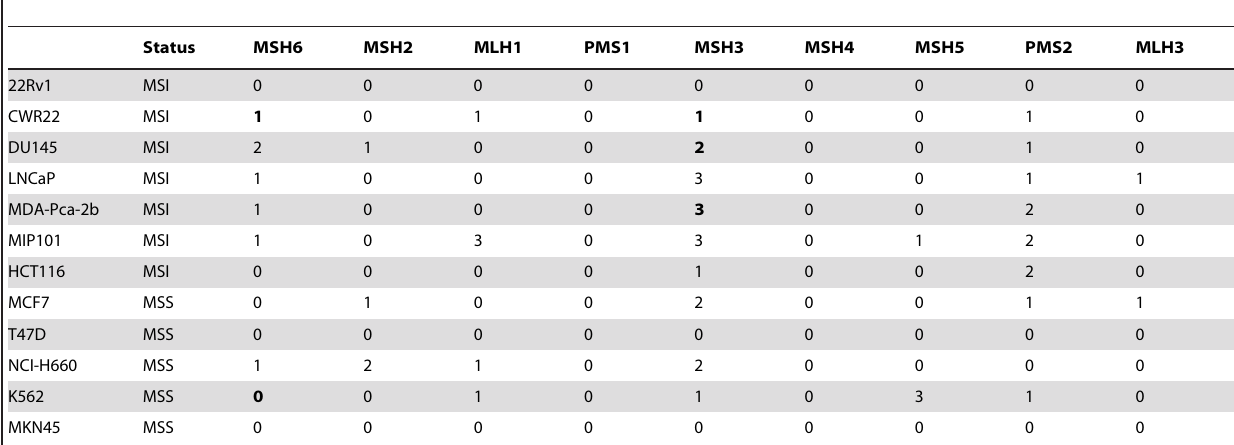
Table 2. MMR gene alterations in cancer cell lines with determined MSI status.